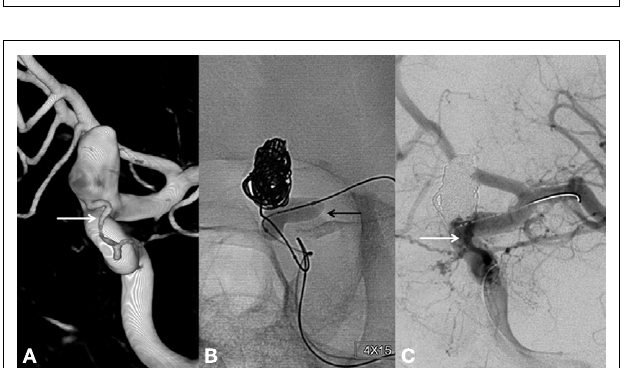
FIGURE 2 |Anteroposterior (A) and lateral oblique (C) left internal carotid artery injection angiogram projections demonstrate coil embolization of a left middle cerebral artery aneurysm with balloon remodeling using theAscent balloon [arrows, (B,D)].